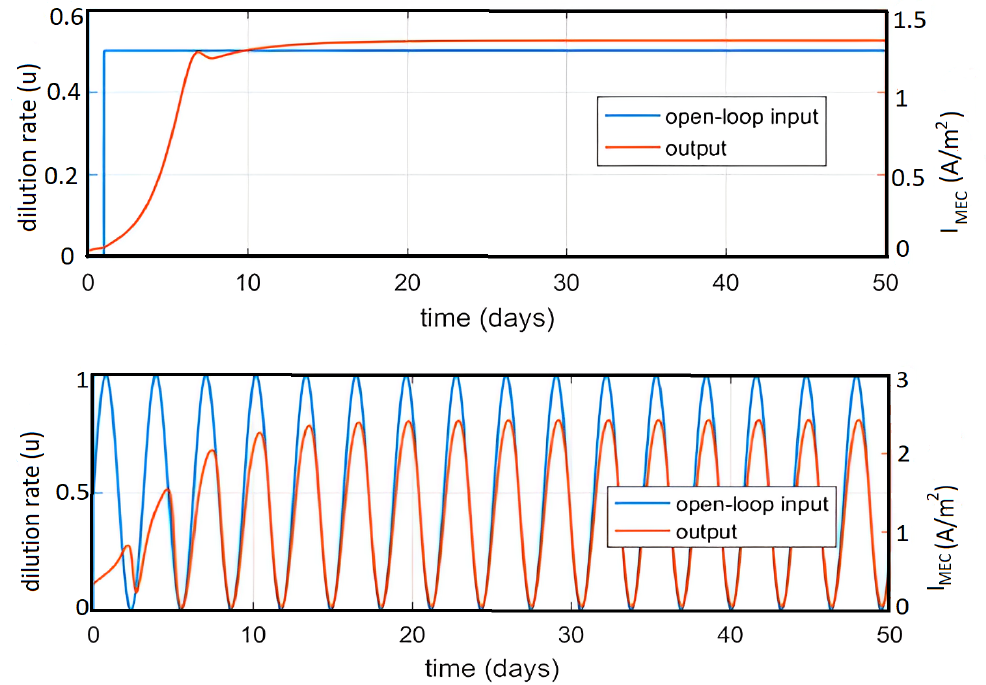
Figure 4. Plots of open loop step (first panel) and open loop sinusoidal (second panel) responses of the continuous MEC